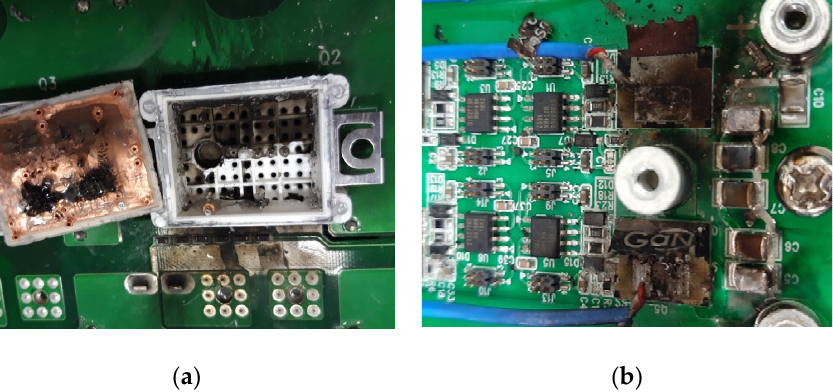
Figure 1. A photograph of burned-out WBG semiconductors by an abnormal switching voltage. ( a ) SiC MOSFET module. ( b ) GaN MOSFET.